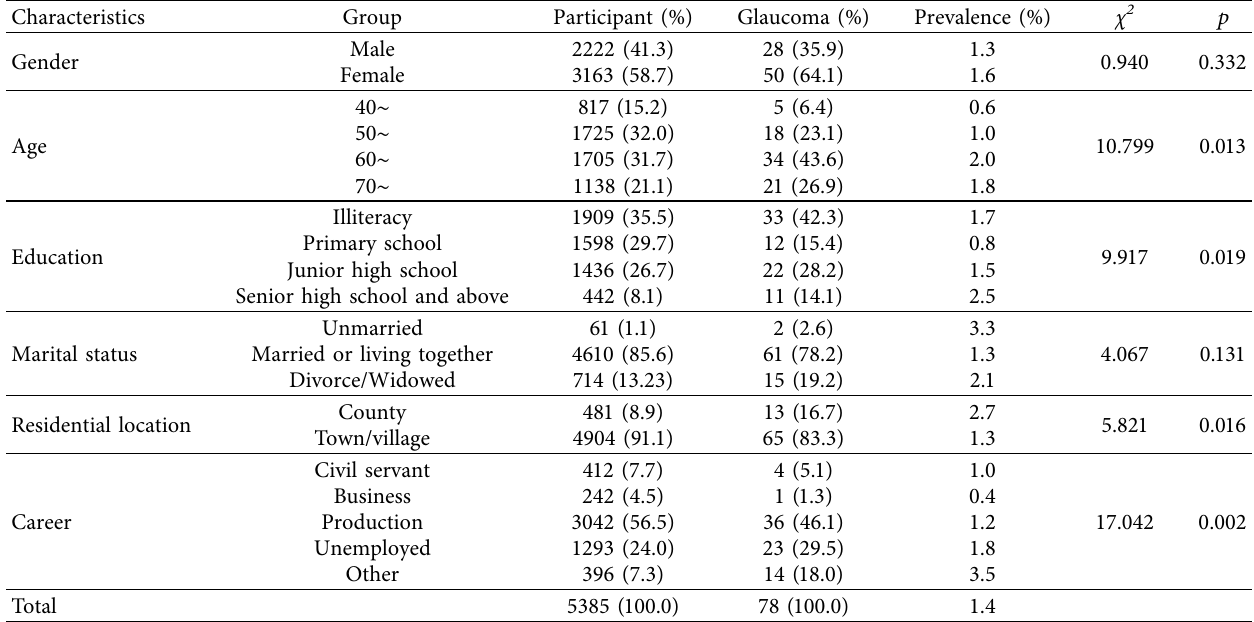
Table 1: The relationship between characteristics of participants and glaucoma ( n �